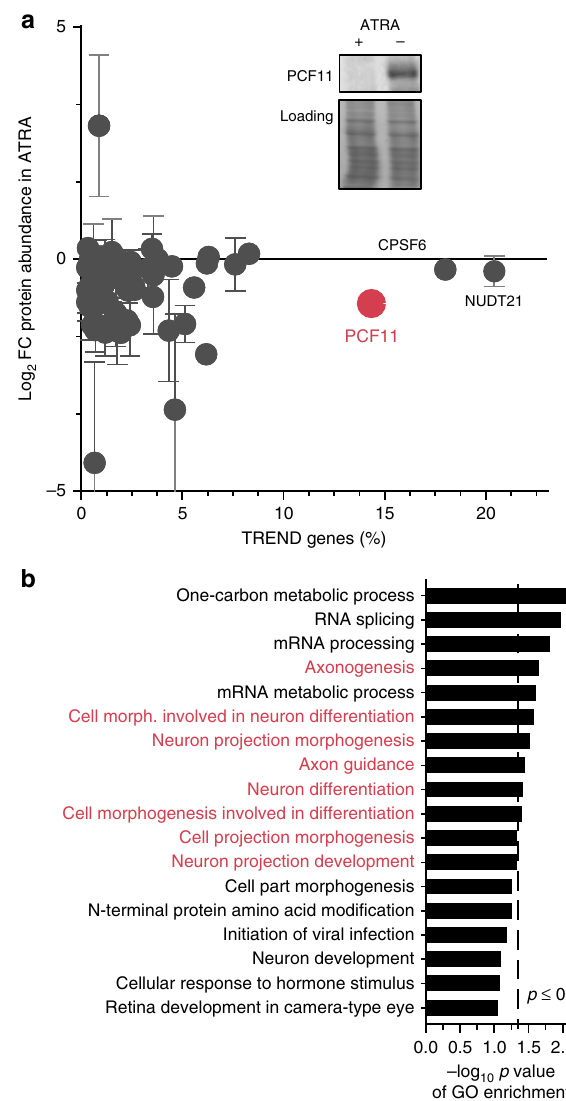
Fig. 3 PCF11 is a key driver of TREND in neuroblastoma with a potential role in neurodifferentiation. a Protein pro fi ling of BE(2)-C cells by western blotting (Supplementary Figure 4) reveals downregulation of PCF11 during ATRA-induced neuroblastoma differentiation (highlighted are the top three TREND-regulators; y -axis, fold-change protein abundance; x -axis, percentage of TREND-affected genes; mean ± s.e.m., two independent replicates; inlet shows a representative PCF11 western blot with equal loading). b PCF11 depletion regulates TREND of target genes with a role in neuronal differentiation (GO enrichment analysis of TREND-affected target genes with a protein change upon PCF11 depletion (obtained by differential mass spectrometry of BE(2)-C cells with and without depletion of